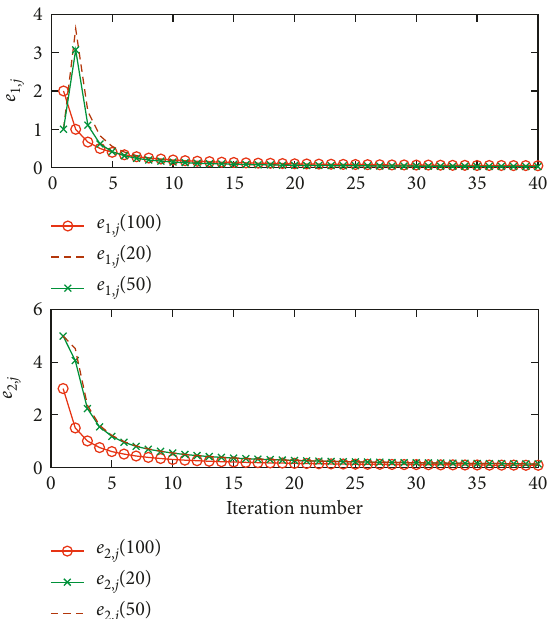
Figure 11: Absolute values of errors e number j .